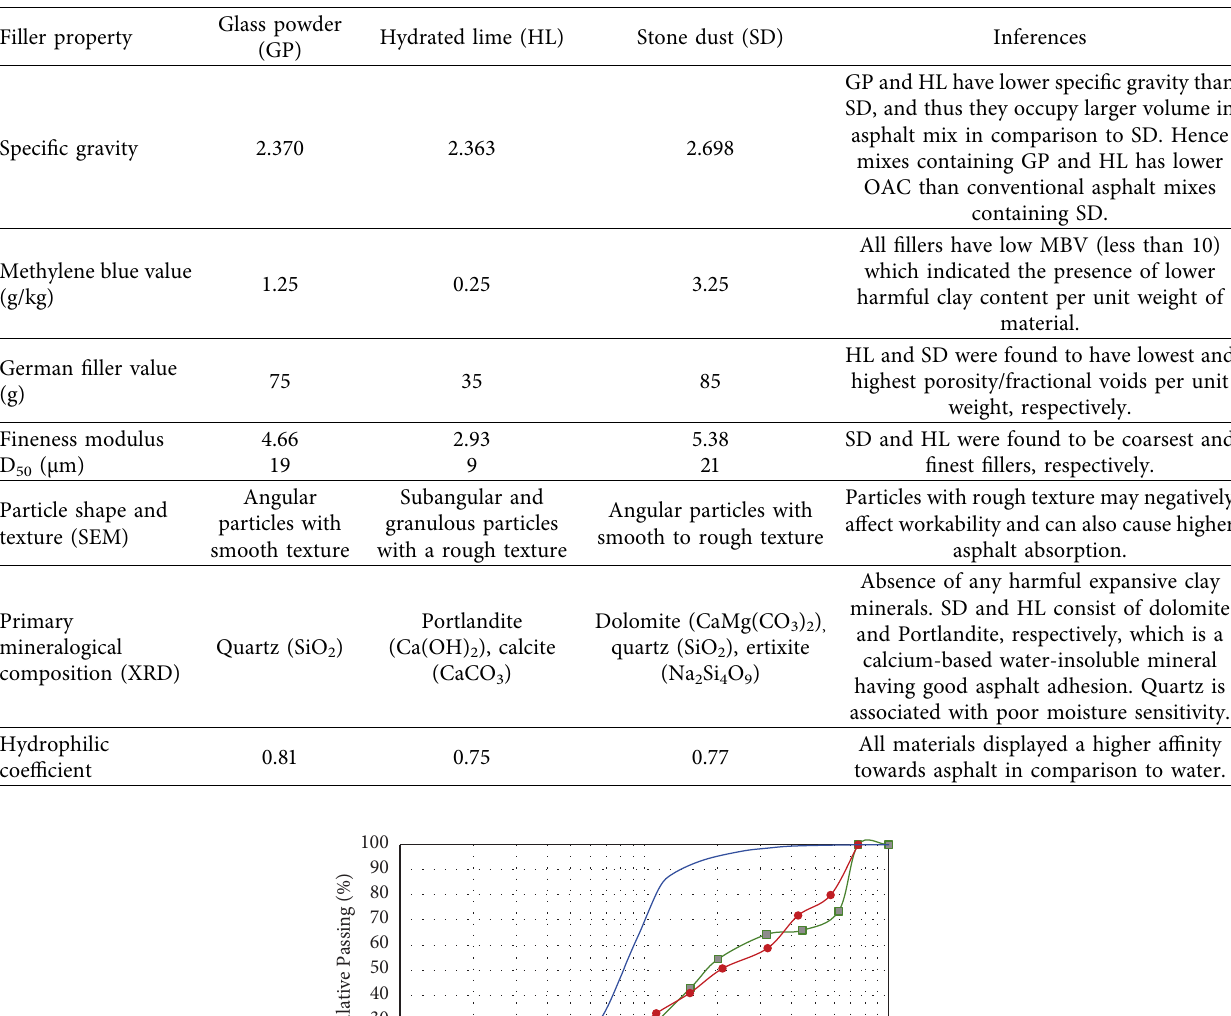
Table 3: Details of characterization properties of